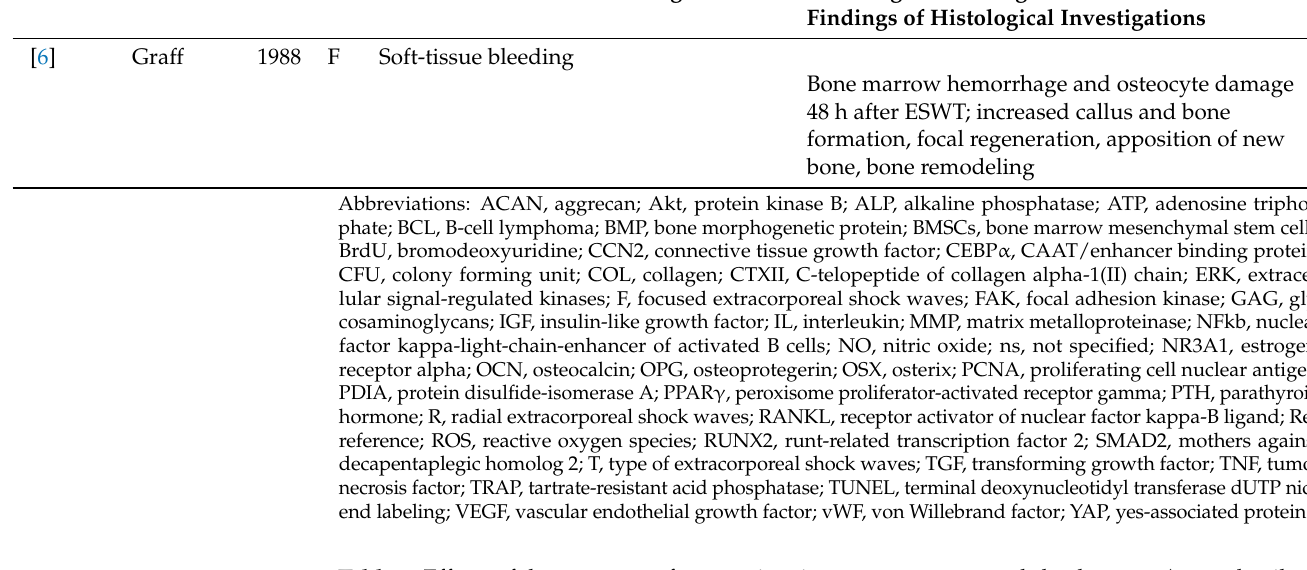
Table 2. Effects of the exposure of connective tissue to extracorporeal shock waves (more details of the studies listed in this table are provided in Table